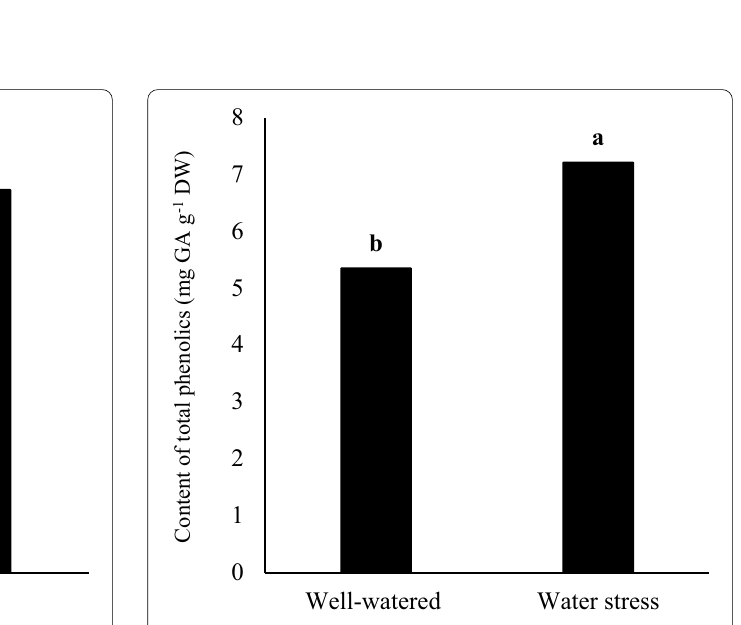
Fig. 3 Main effect of year on content of total phenolics Fig. 4 Main effect of irrigation levels on content of total